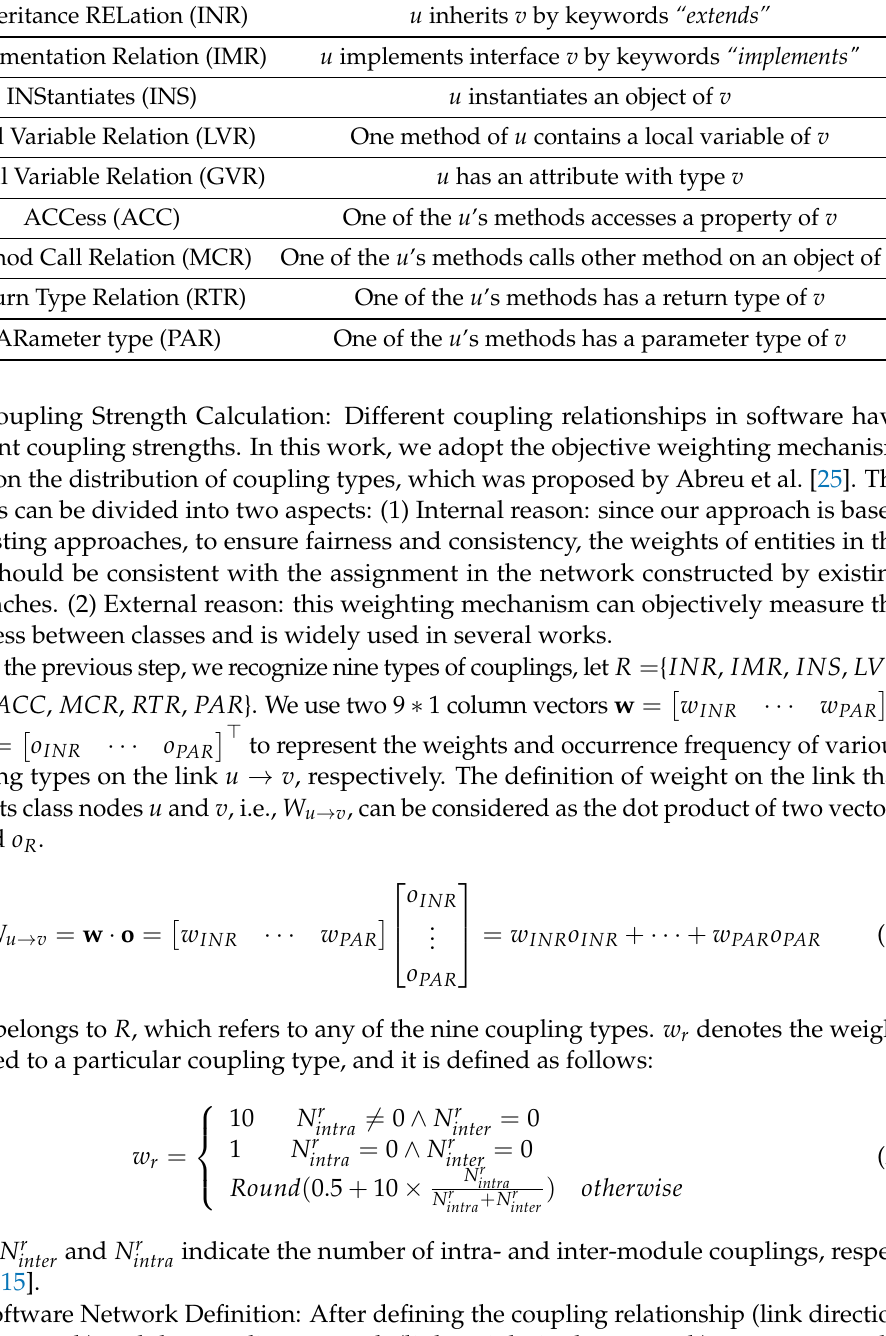
Table 1. Descriptions of the coupling relationships. Relationship